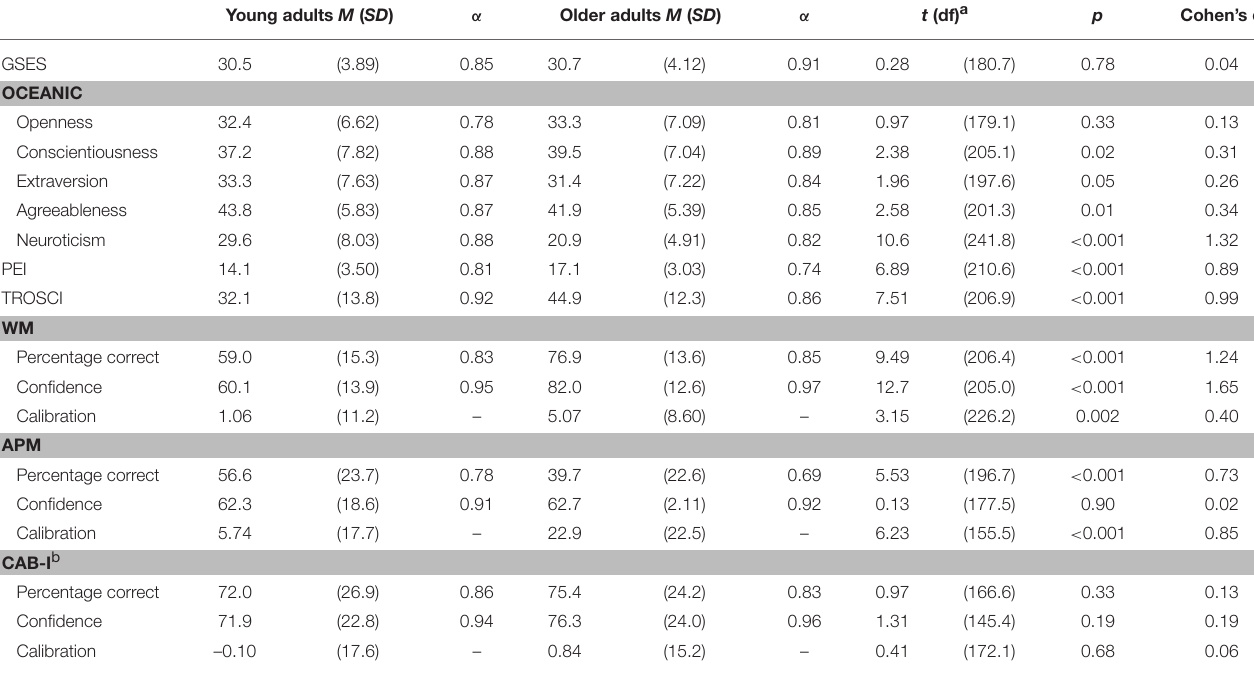
TABLE 2 | Descriptive statistics for all dependent variables with comparison between group scores for young ( n = 153) and older adults ( n = 91).